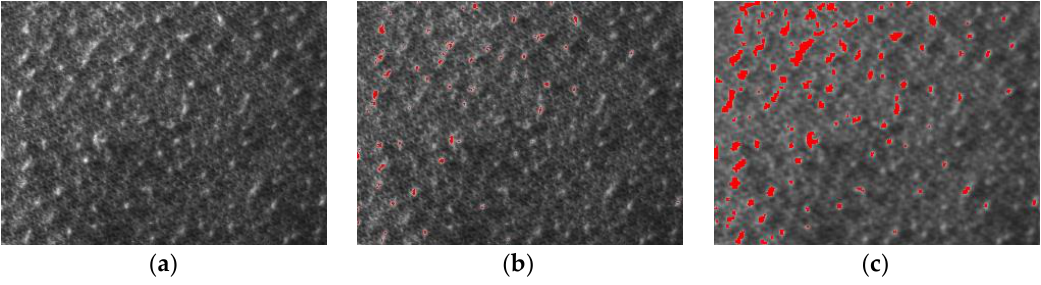
Figure 16. ( a ) Original image, ( b ) red region representing pilling (without image preprocessing), and ( c ) red region representing pilling (with image preprocessing).